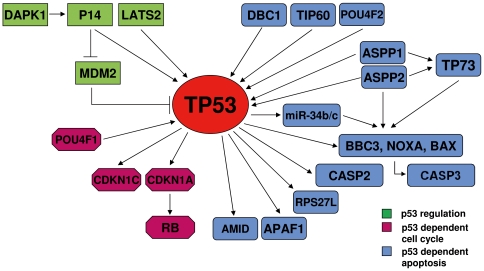
Outline of the genes involved in the TP53 pathway.